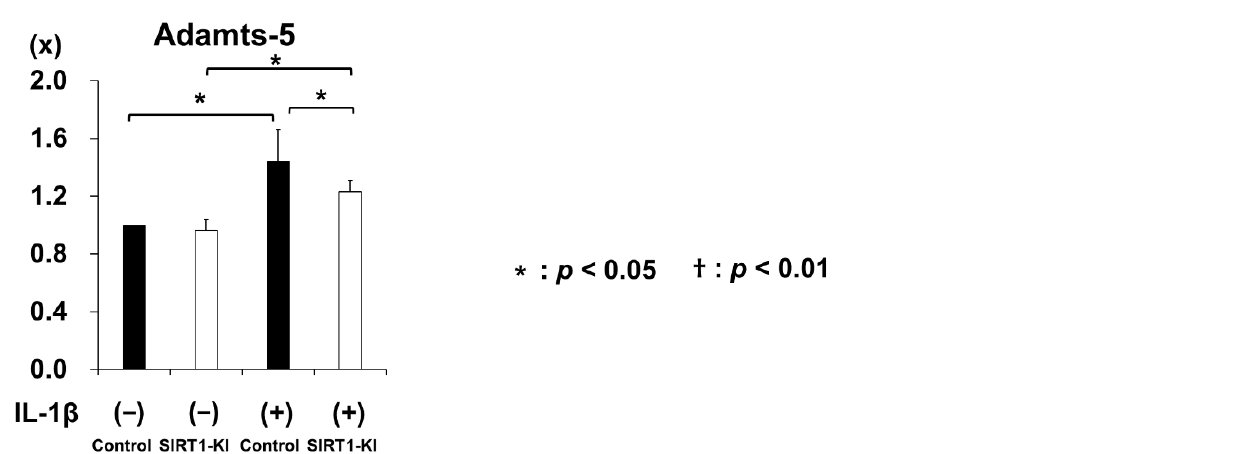
Figure 5. Real-time polymerase chain reaction (PCR) analysis of Sirt1, Col2a1, Col10a1, Mmp-3, Mmp-13, Aggrecan, and Adamts-5 mRNA expression in primary mouse chondrocytes. Primary mouse epiphyseal chondrocytes were cultured with 10 ng/mL IL-1 β for 24 h ( n = 5 independent experiments; * p < 0.05, † p < 0.01).